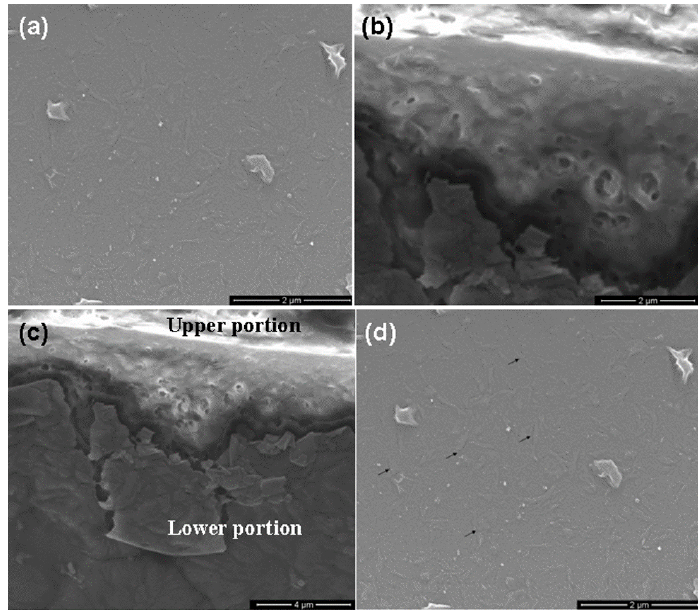
Figure 4. Scanning electron microscopy (SEM) images of as-deposited porous GaAs (sample A). ( a ) surface, ( b ) cross-section view, ( c ) cross-section view showing upper and lower portions, ( d ) pores shown by arrow on surface.